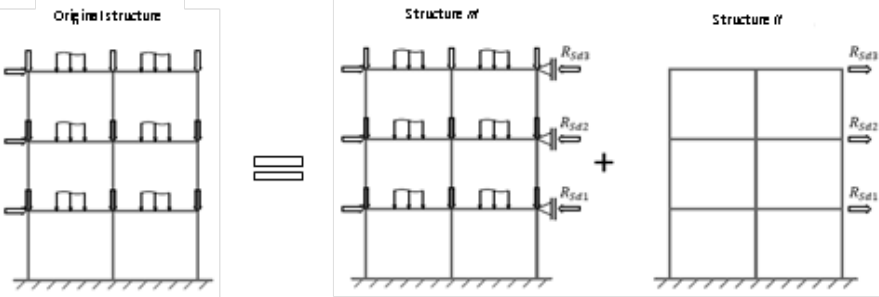
Figure 1 – Original structure divided into two models. Source: Badke-Neto and Ferreira